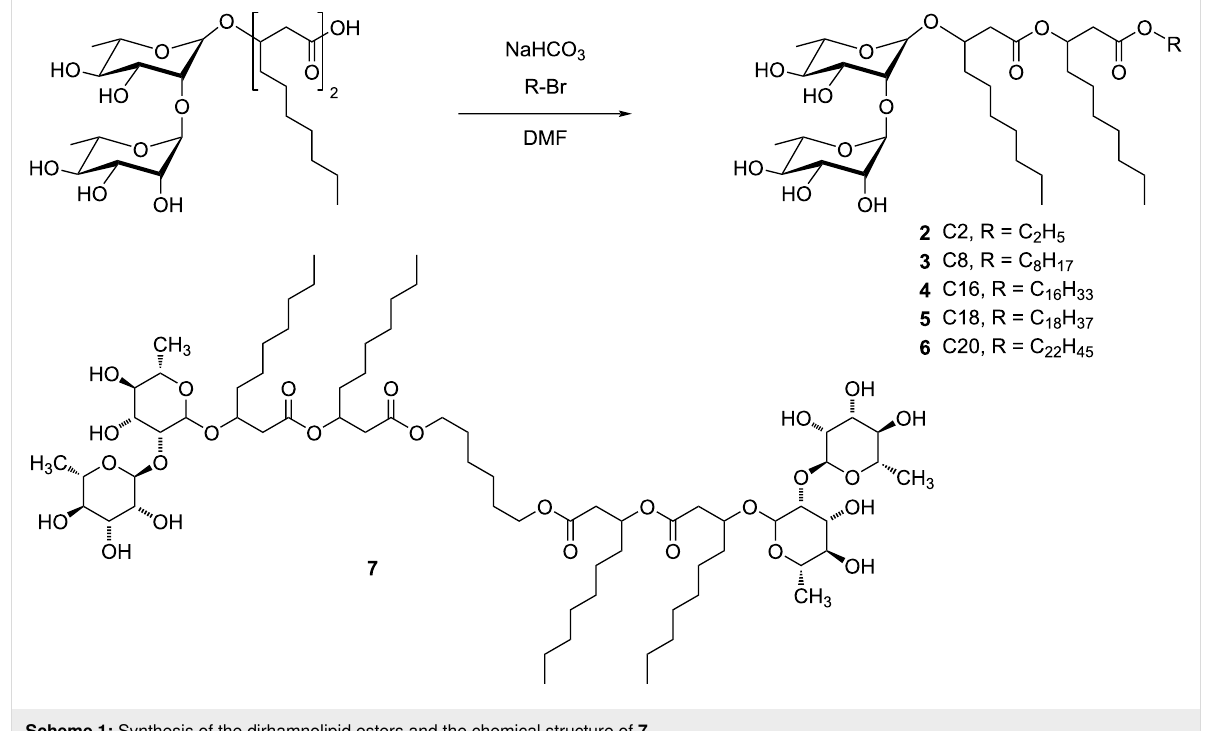
Scheme 1: Synthesis of the dirhamnolipid esters and the chemical structure of 7 .